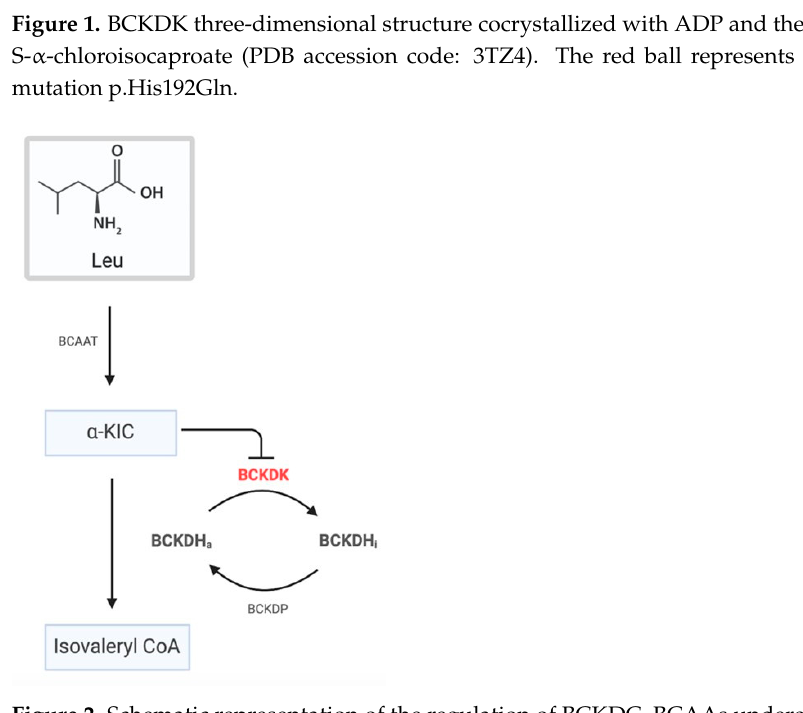
Figure 1. BCKDK three-dimensional structure cocrystallized with ADP and the synthetic inhibitor S- α -chloroisocaproate (PDB accession code: 3TZ4). The red ball represents the location of the muta- tion p.His192Gln.